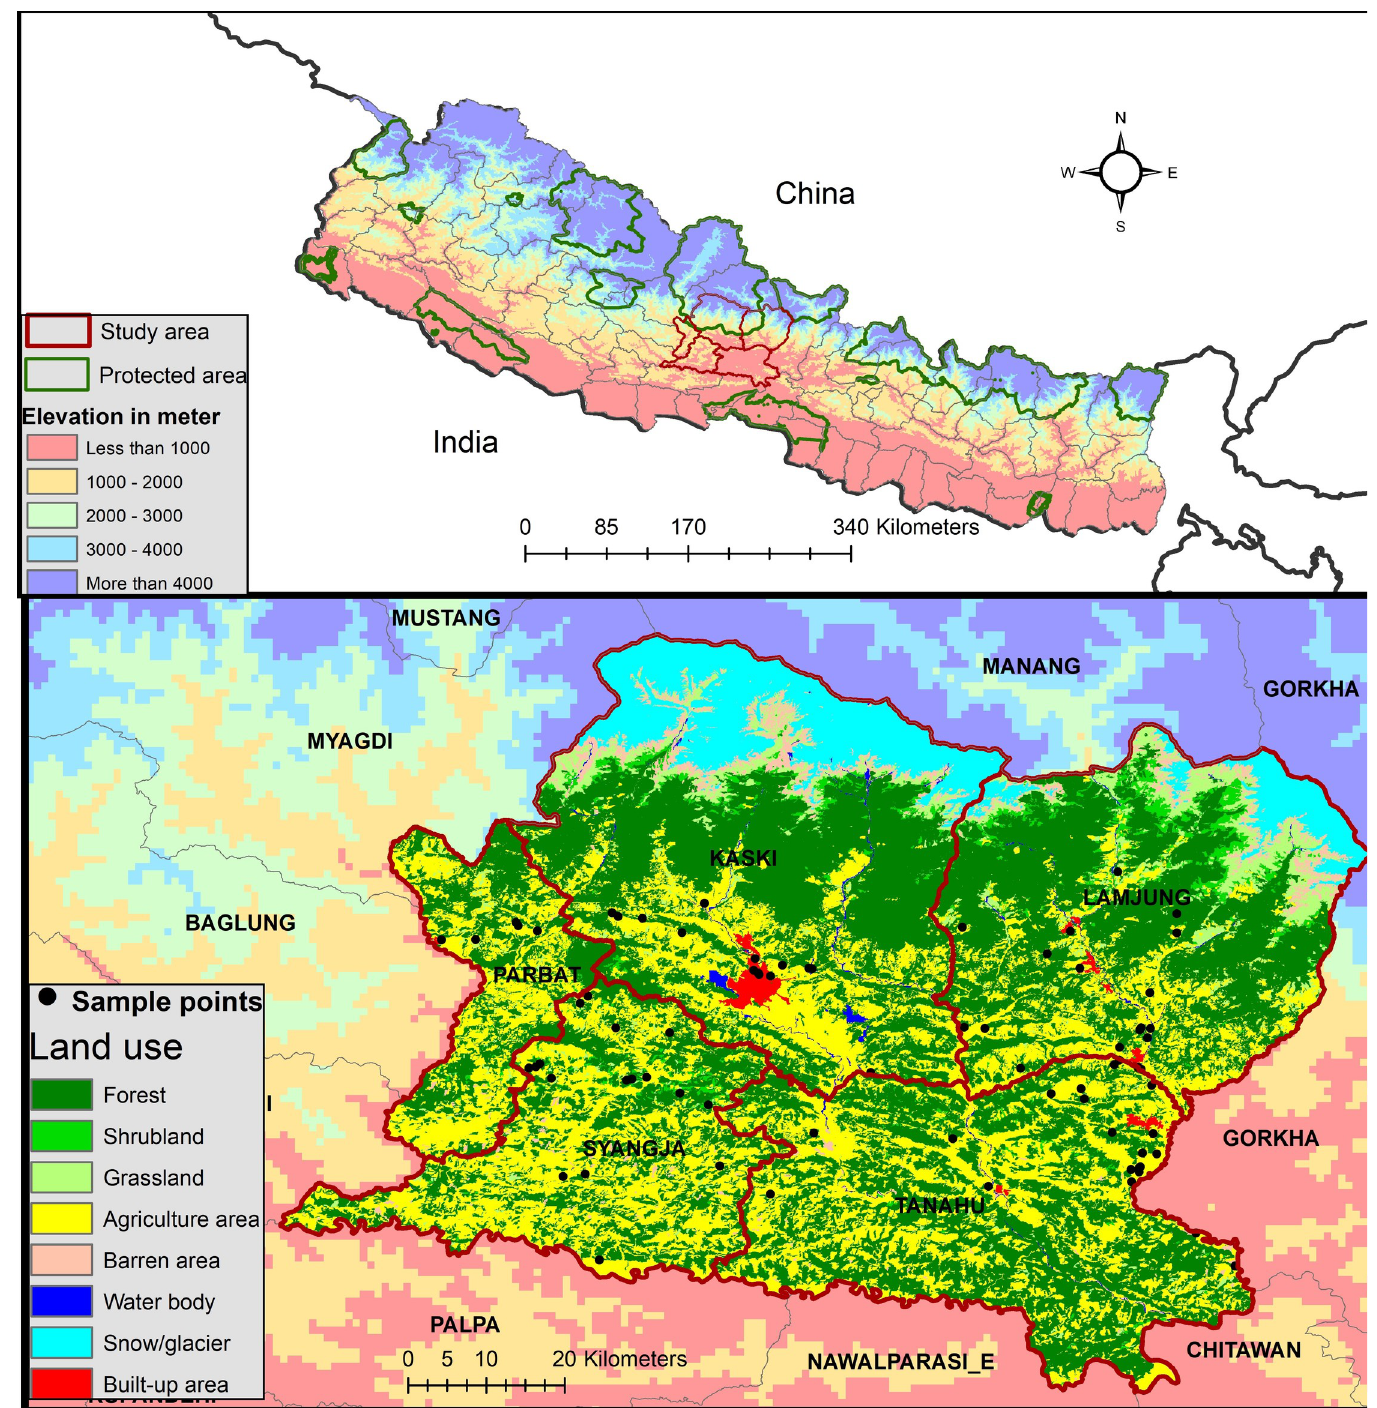
Fig 1. Location of study area showing the districts, elevation, land use and points of wildlife attacks. “Republished from [51] under a CC BY license, with permission from ICIMOD, original copyright 2010”.